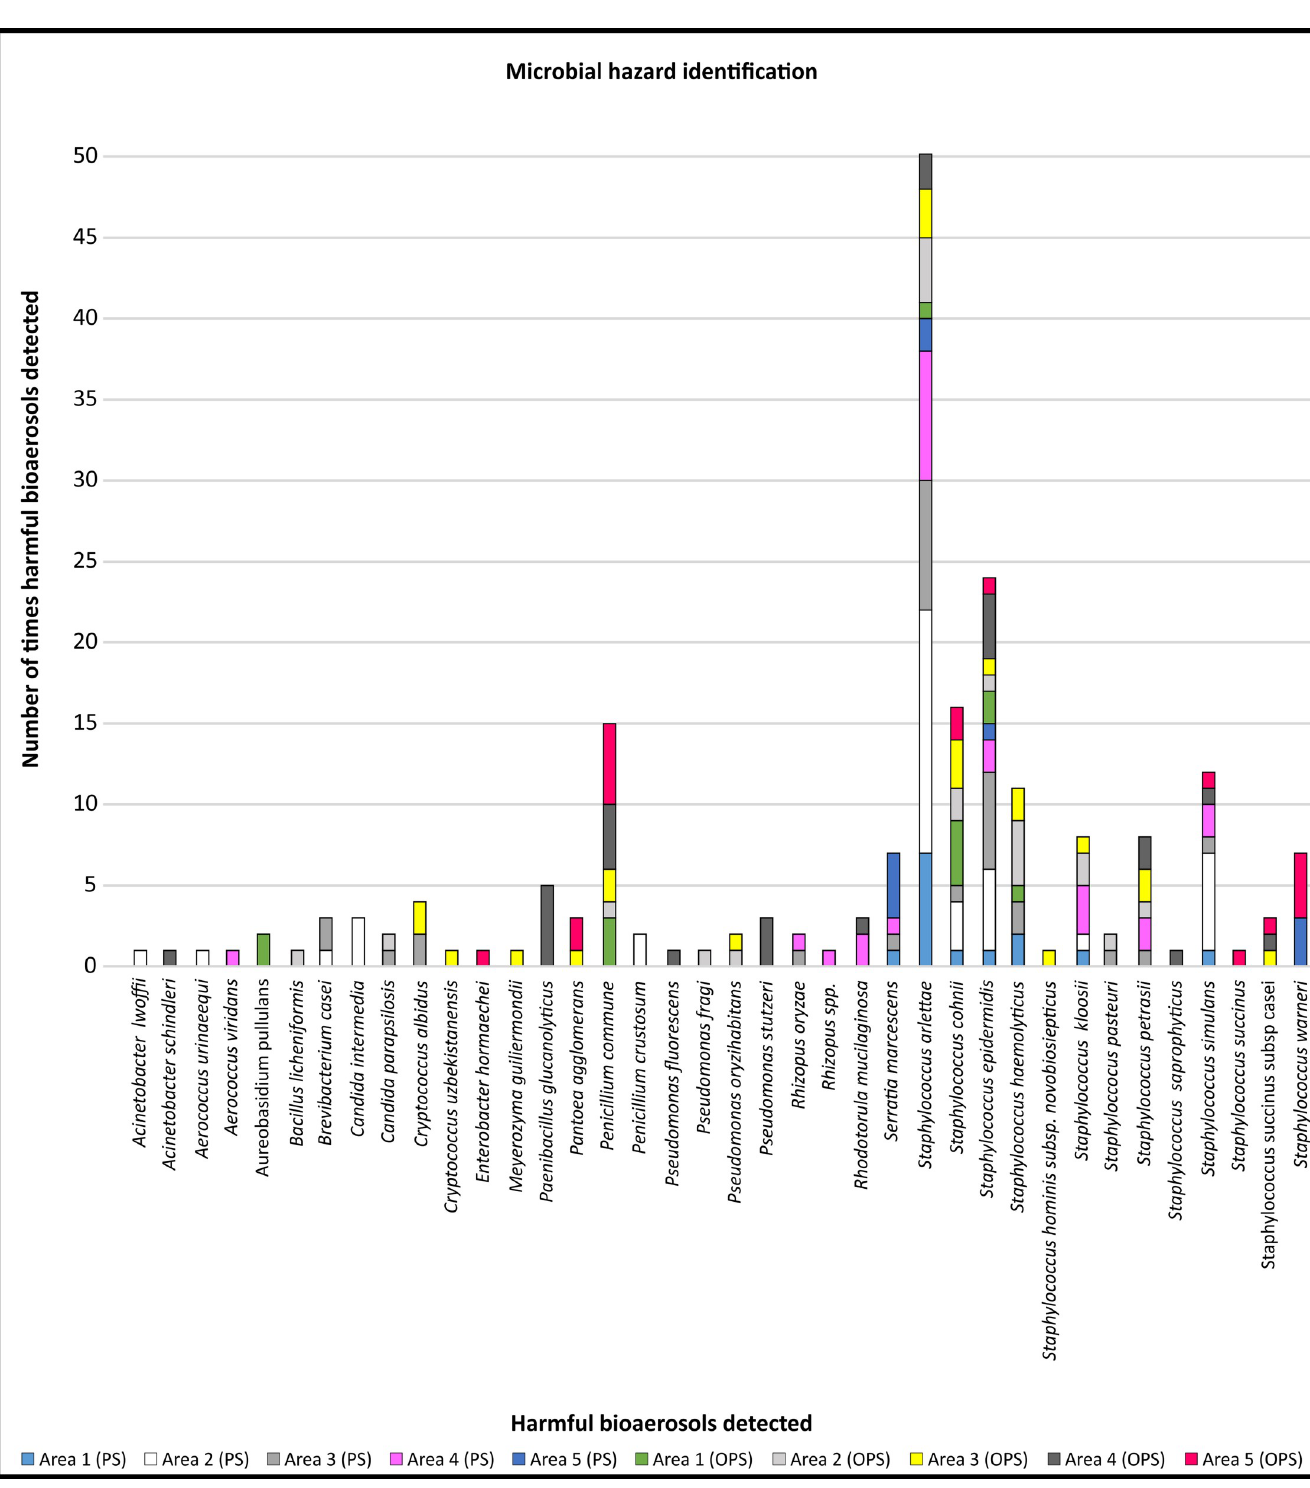
PLOS ONE | https://doi.org/10.1371/journal.pone.0242969 April 21, 2021 14 /